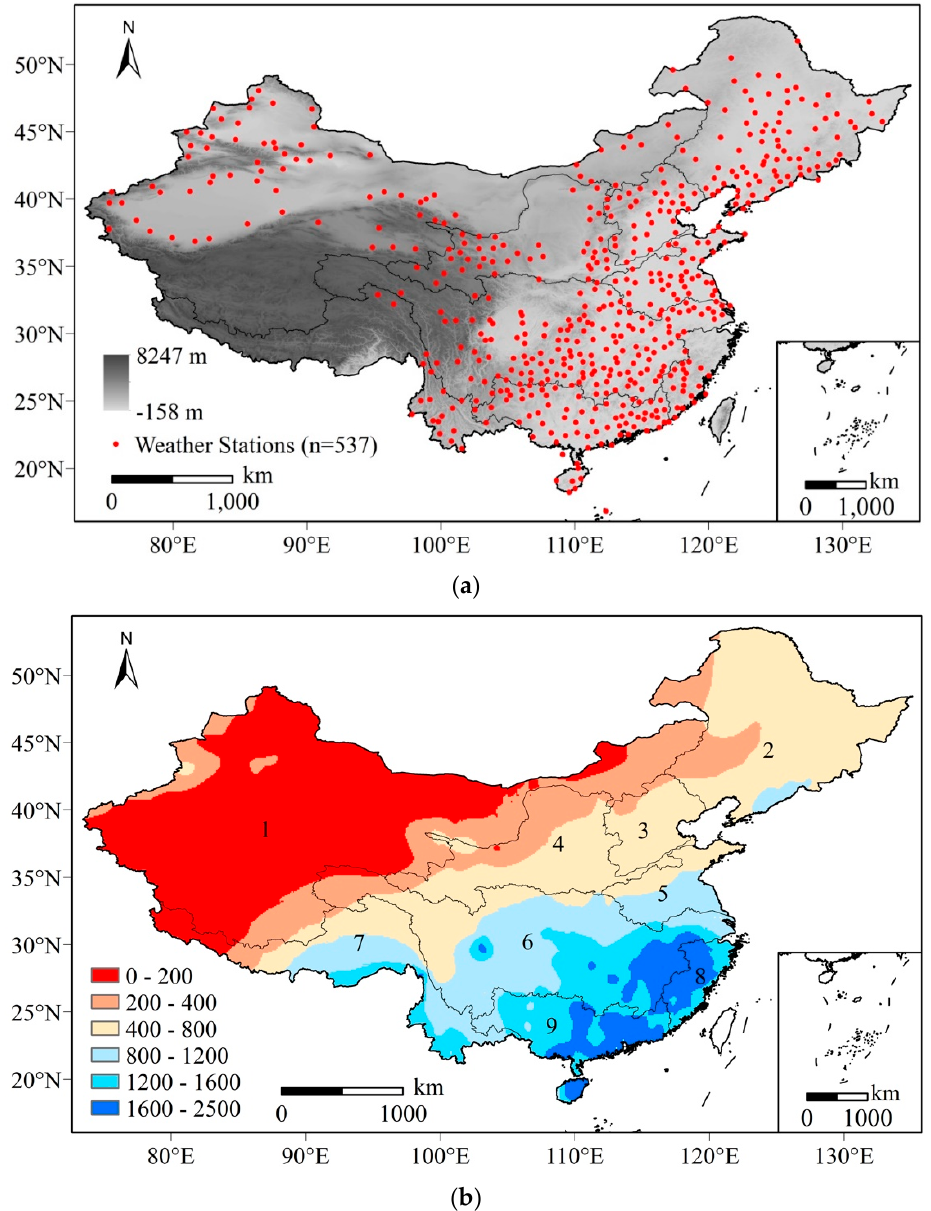
Figure 1. Precipitation data from 537 stations over China during the period 1961–17. ( a ) Location of 537 weather stations and topography over China; and ( b ) Annual precipitation (mm) and nine major river basins in China (1 = Continental River Basin; 2 = Songliao River Basin; 3 = Haihe River Basin; 4 = Yellow River Basin; 5 = Huaihe River Basin; 6 = Yangtze River Basin; 7 = Southwest River Basin; 8 = Southeast River Basin; 9 = Pearl River Basin).